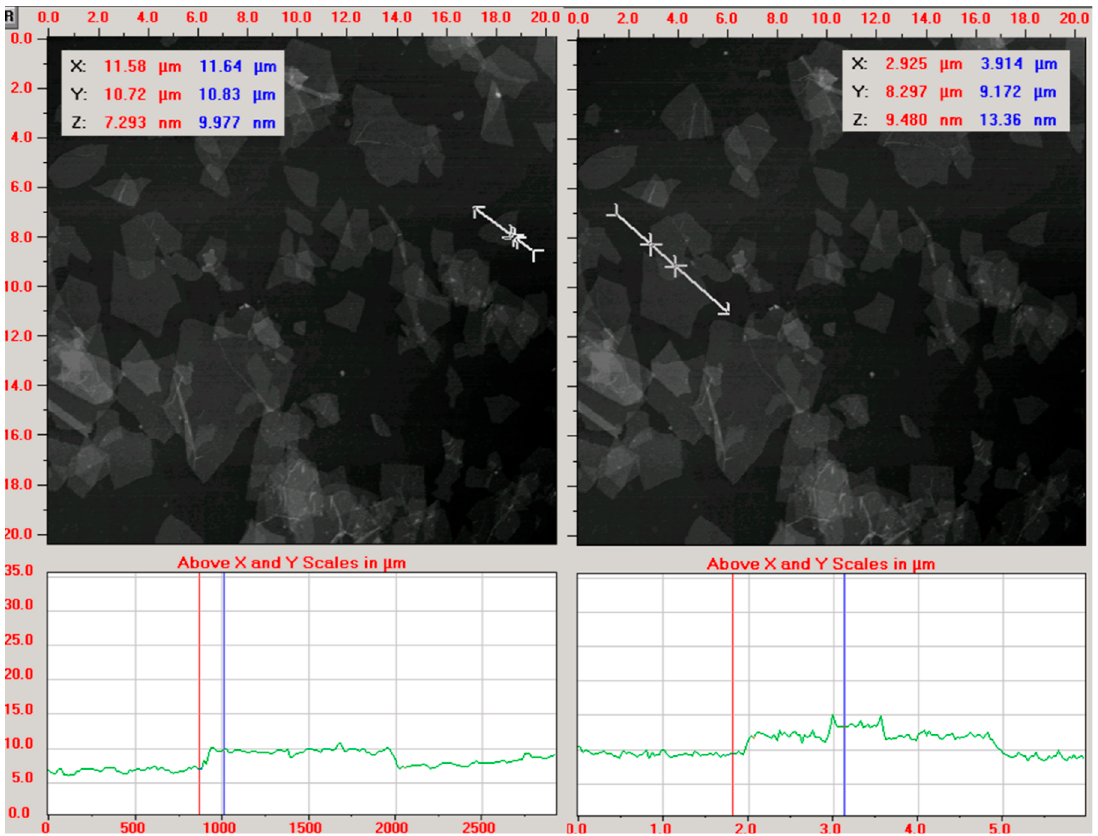
Figure 2. AFM measurement of GO flakes. X and Y scales are in μ m and Z scale is in nm. Z axis corresponds to GO flake thickness. Left profile shows the thickness of a single GO flake (2.7 nm) and the right shows the GO thickness of a single flake (2.5 nm) and two flakes that overlap (3.4 nm). Abbreviations: AFM, atomic force microscope; GO, graphene oxide.